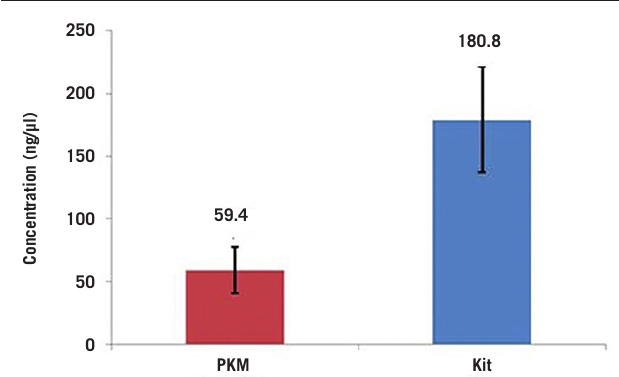
FigurE 1 − Mean values of the concentrations of samples extracted by the two methods PKM: proteinase K